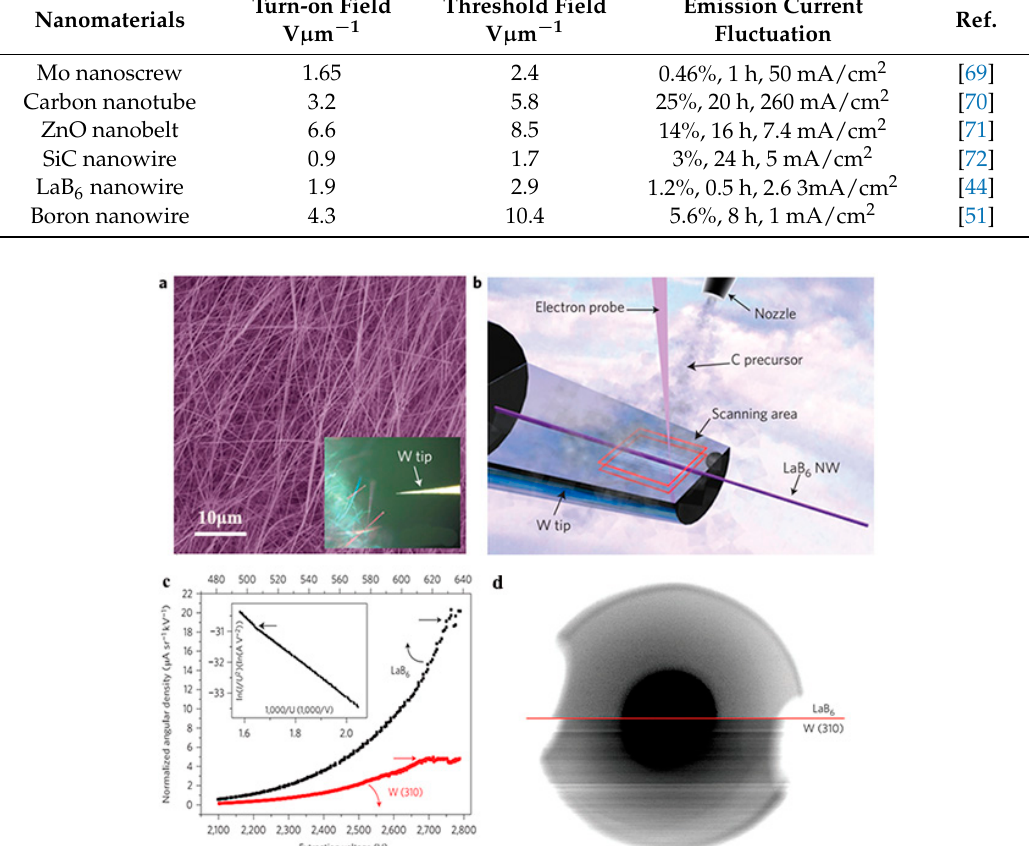
Figure 10. ( a ) SEM image of LaB 6 nanowires (NWs) on a monocrystalline LaB 6 (100) substrate. The inset shows the optical image in which a LaB 6 nanowire is picked up by a W tip. ( b ) Schematic diagram showing the electron beam deposition process of fixing a LaB 6 NW onto a W needle. ( c ) The dependence of normalized angular current density on extraction voltage with maximum value limited by emission instability. The inset gives their corresponding F–N plots, showing linearity with a transition point at high current density. ( d ) Signal noise comparison for imaging the acceleration electrode in the SEM objective lens using the LaB 6 NW emitter and W emitter, respectively [68]. Copyright 2016, Springer